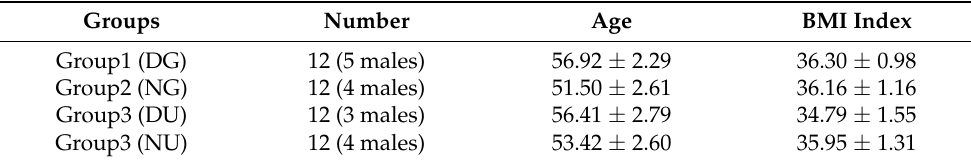
Table 1. Basic information of participants from each group. Groups Number